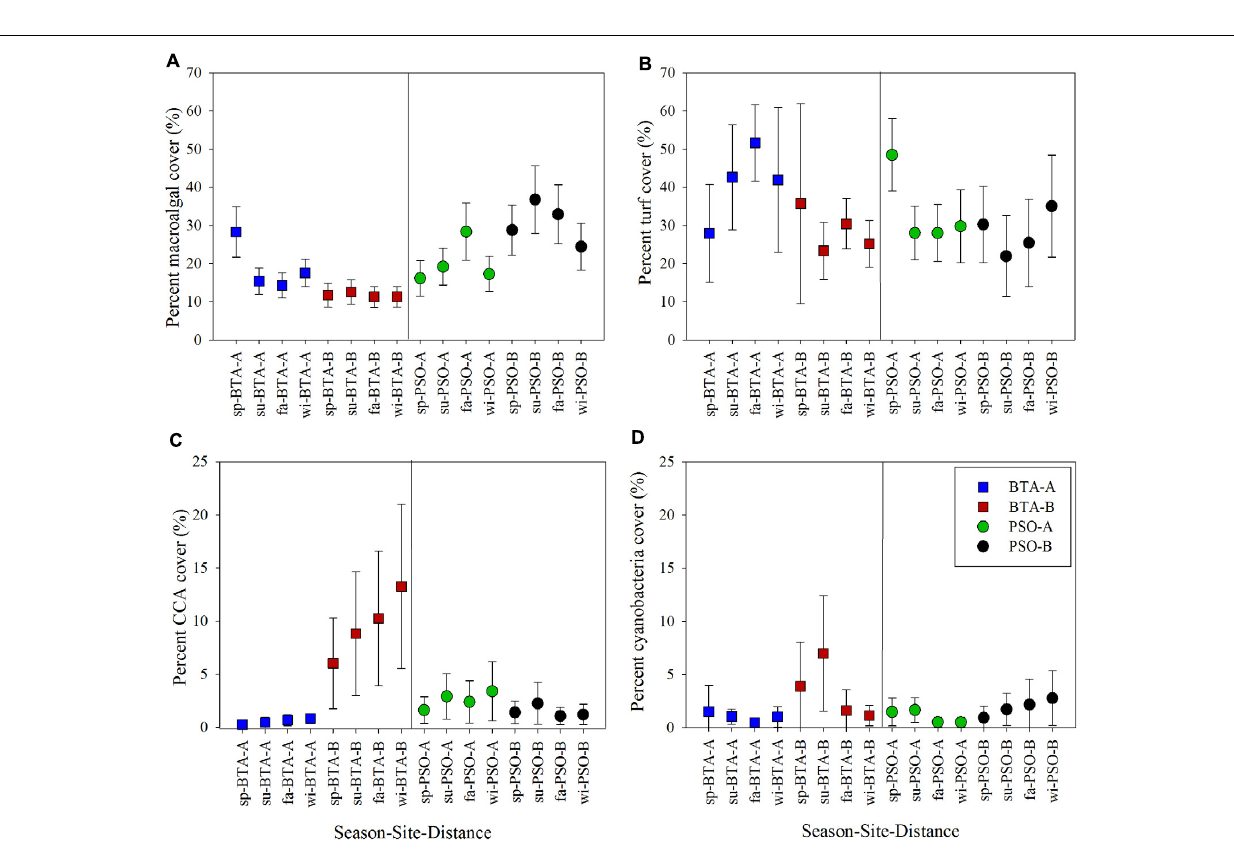
FIGURE 9 | Coral reef benthic components cover across a distance gradient from shore, site, and seasons (mean ± 95% CI). Percent macroalgal cover (A) , turf (B) , crustose coralline algae (CCA) (C) , and cyanobacteria cover (D) . Blue and red squares represent Bahía Tamarindo (BTA); green and black represent Punta Soldado (PSO). Seasons are defined as: sp, spring; su, summer; fa, fall; wi,